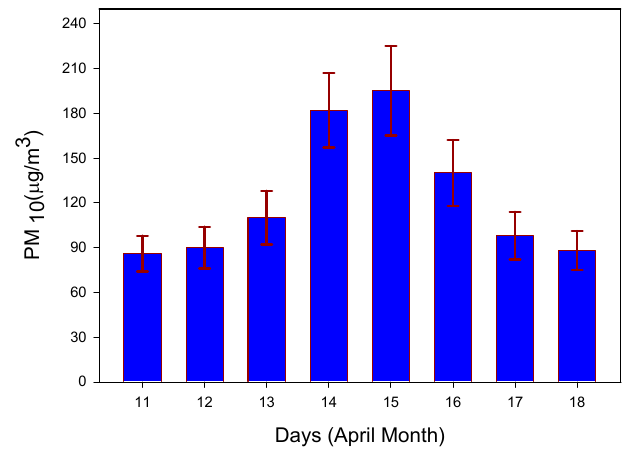
Figure 4. Variation of PM 10 (24 h) concentration during pre ‐ , post ‐ , and Vishu days. PM—particulate